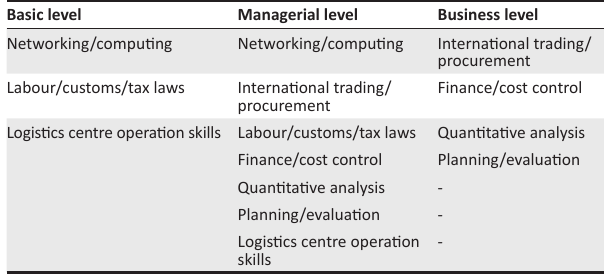
FIG URE 7: T-shaped skills framework. TABLE 7: Expertise level skills requirements.